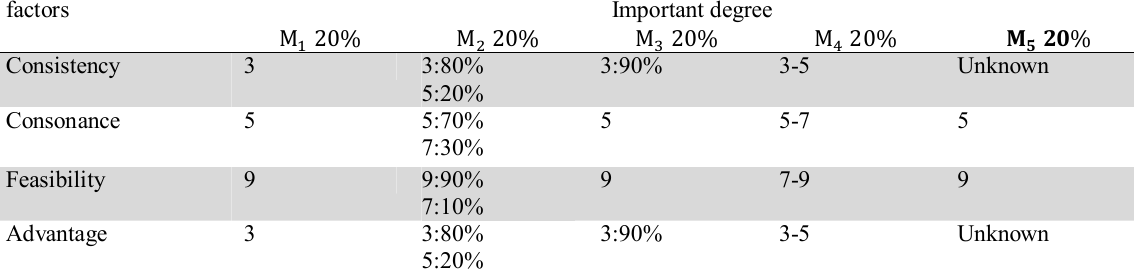
Assessment the relative importance of Rumlet